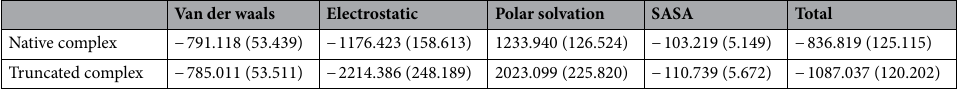
Table 1. Decomposition of the IL-1RA/IL-1R1 and T-IL-1RA/IL-1R1 energies by interaction type